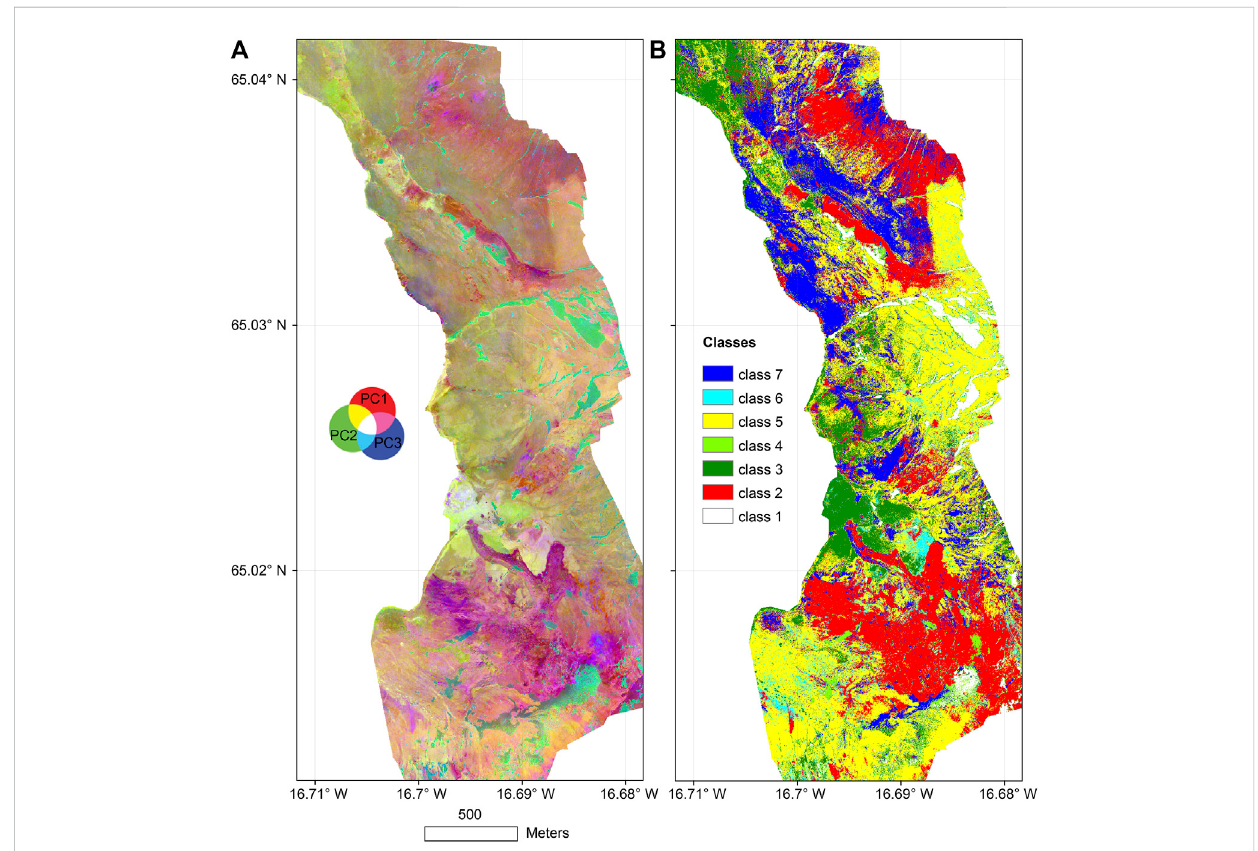
FIGURE 7 Results of the drone data analysis. (A) RGB composite of PC1 to PC3 and (B) classi fi cation results displaying the areal extents of classes 1 to